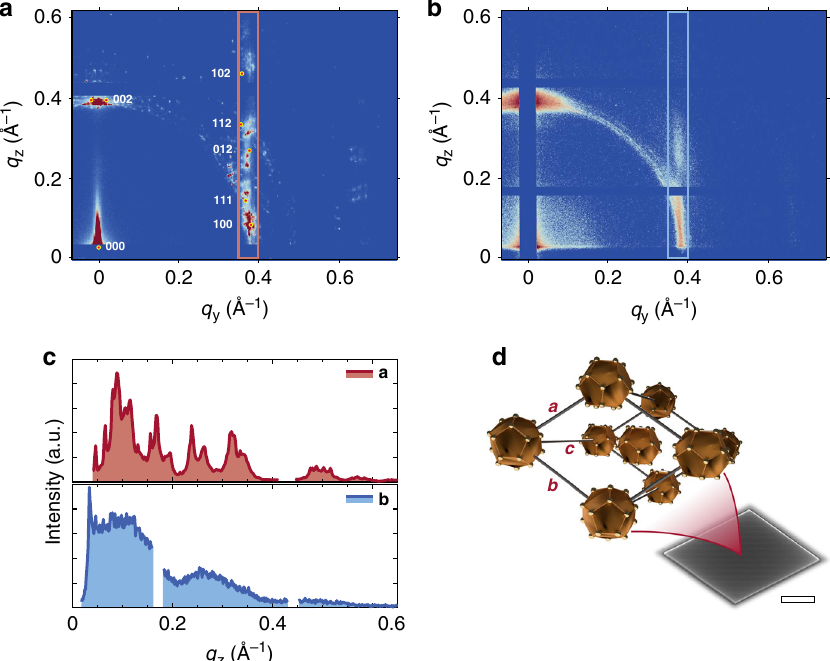
Fig. 2 Structure of Au 32 -NC microcrystals. a Grazing-incidence small-angle X-ray scattering (GISAXS) pattern of an ensemble of hundreds of microcrystals with different azimuthal orientation. Diffraction spots are simulated according to a triclinic unit cell ( a = 1.90 nm, b = 1.94 nm, c = 3.48 nm, and α = 72°, β = 86°, γ = 59°). b GISAXS pattern of a spin-coated thin fi lm of Au 32 -NCs. Note that the images (a) and (b) in the chosen geometry ( q y , q z ) exhibit a very small distortion of the Ewald sphere, which is neglected here. c Line scans along q z at q y = 0.37 Å − 1 of the pattern in red ( a ) and blue ( b ), respectively, highlighted by the rectangular boxes. The ensemble of microcrystals ( a ) show distinct sharp peaks, indicating the high crystallinity. The polycrystalline sample ( b ) shows broad signals while lacking clear peaks, indicating the polycrystalline and defect-rich structure. Gaps correspond to detector edges. d Schematic drawing of the triclinic unit cell with axis a , b , and c indicating the idiomorphic growth of the displayed microcrystal. The unit cell contains two crystallographically independent NCs. Ligand spheres are omitted for clarity. The scale bar of the SEM micrograph of a microcrystal corresponds to 3 µ